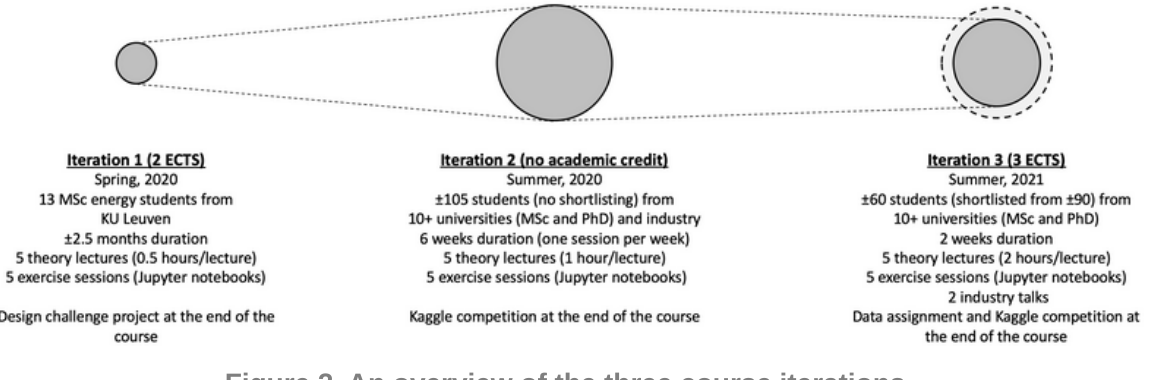
Figure 2. An overview of the three course